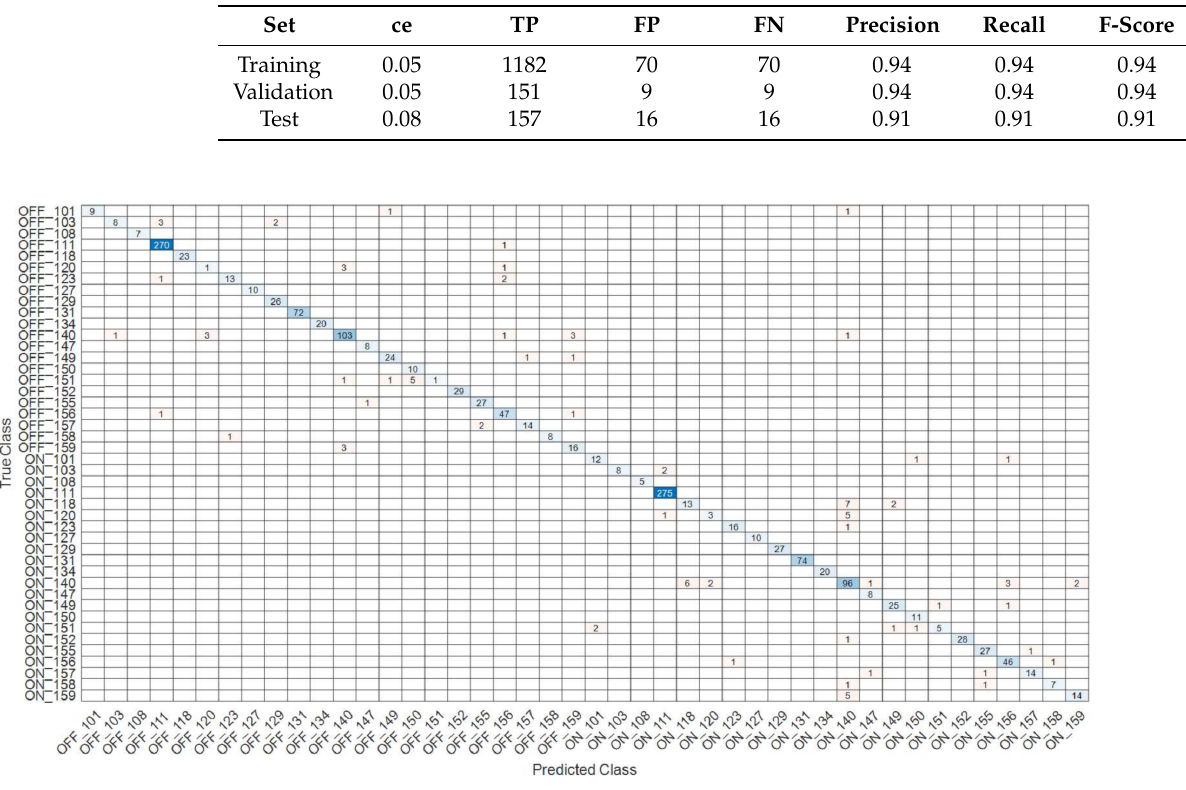
Table 4. Performance of MLP trained with the top 8 features.